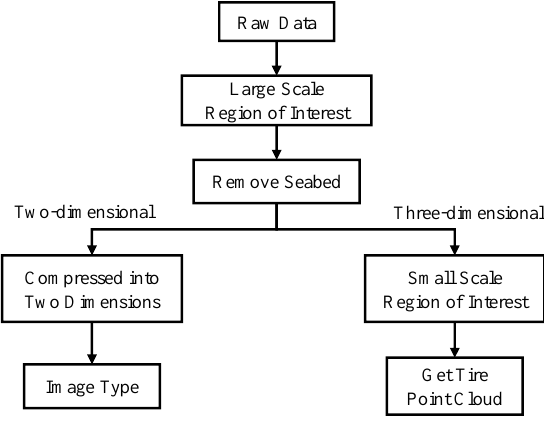
Figure 2. Data pre-processing flow chart.